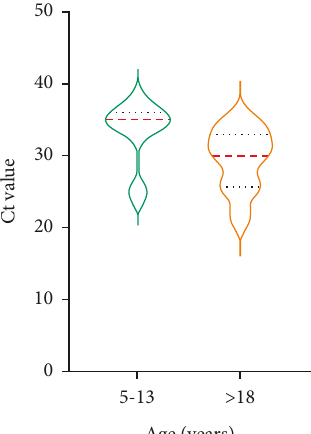
Figure 4: Ct values of oropharyngeal nucleic acid tests in asymptomatic patients stratified by